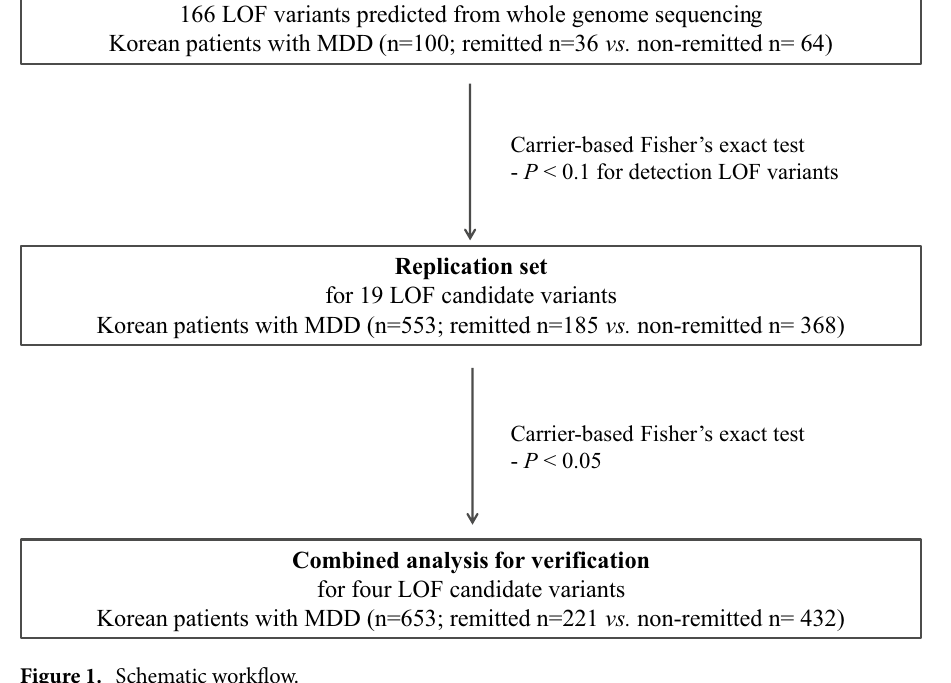
Figure 1. Schematic